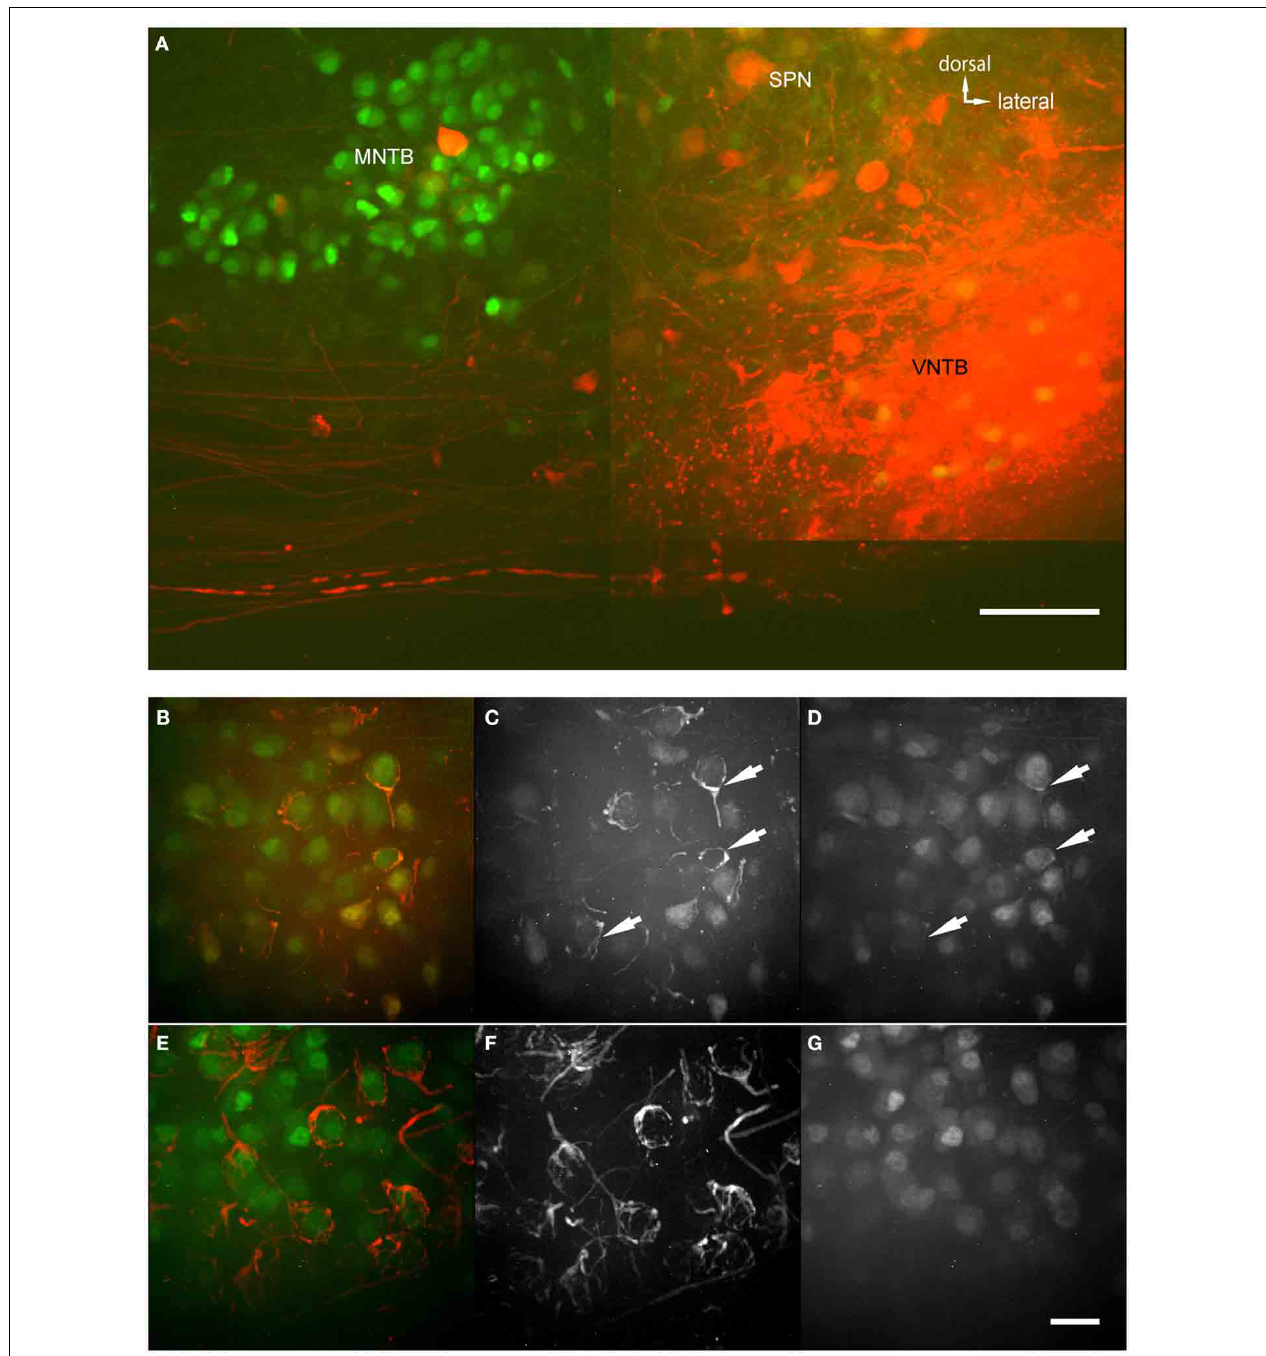
FIGURE 6 | Anterograde injections into VNTB reveal connections to MNTB neurons. (A) Brain stem section of a case where TMR was injected into the VNTB of a p14 GlyT2-GFP mouse. The image shows the injection site within the VNTB, as well as the ipsilateral MNTB. A number of axons projects from the injection area to the ipsilateral MNTB and appears to terminate there. The image consists of a total of 4 tiled confocal stacks; the image depth of the original stack was 300 µ m. Before imaging, the section was cleared using the Clear T2 -protocol. (B–D) magnifications from the ipsilateral MNTB of a p14 brain that was cleared with the technique, showing a variety of labeled presynaptic elements. (B) Represents the overlay of both channels (red: TMR,